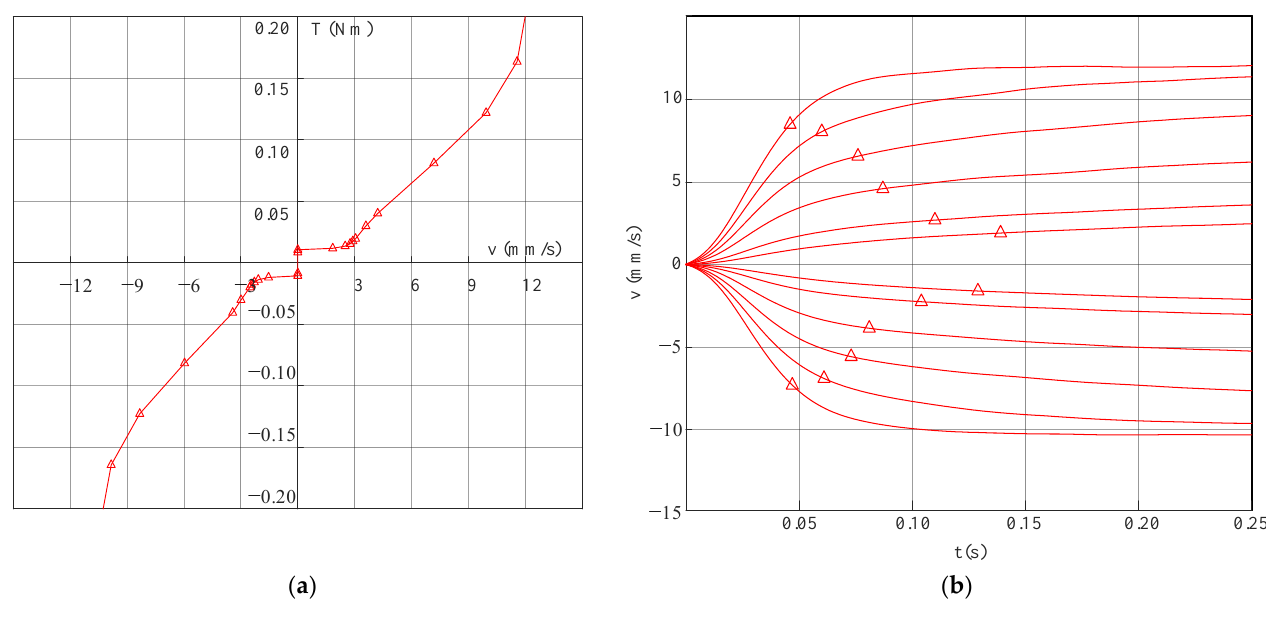
Figure 2. ( a ) Friction model of the system. ( b ) Velocity of carriage at 24.0, 19.2, 14.4, 9.6, 4.8, 2.4, − 2.4, − 4.8, − 9.6, − 14.4, − 19.2, − 24 V applied to the PMDC motor, from top to bottom. The triangles showing 70% of the terminal velocity indicate the speed response of the system.